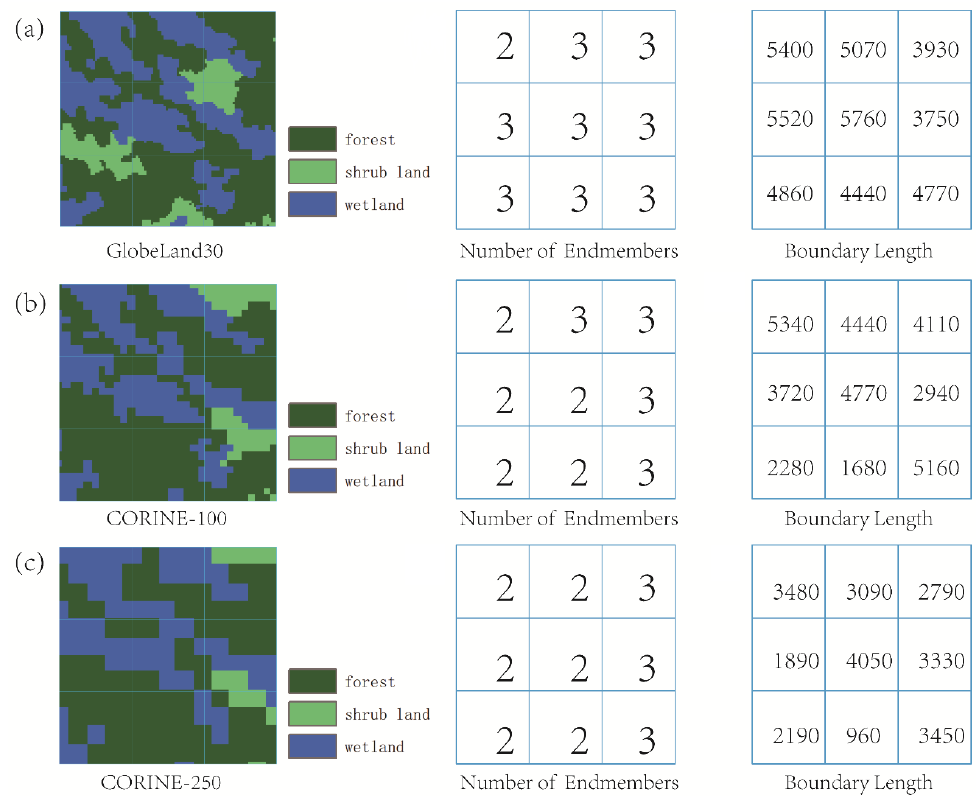
Figure 10. Comparison between input land cover data with different resolutions.